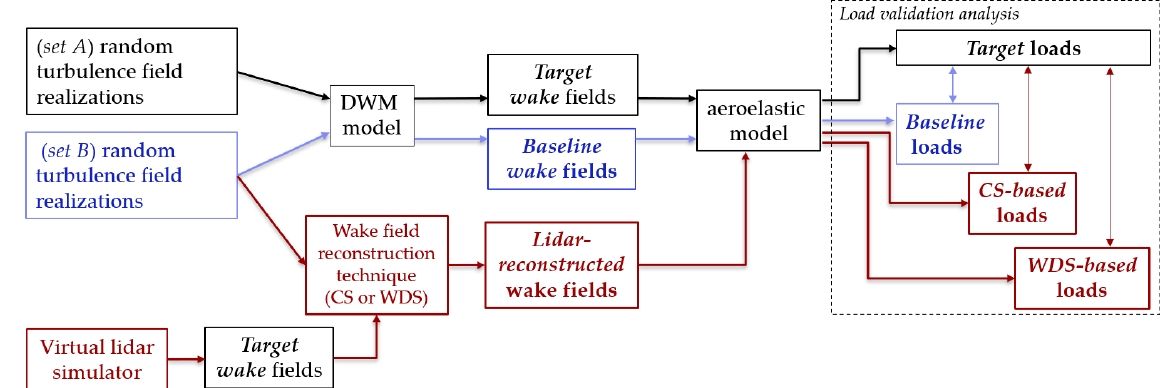
Figure 1. An illustration of the numerical framework utilized to reconstruct wake fields through the DWM model and our proposed lidar- based wake field reconstruction techniques (i.e., the constrained simulations, CSs, and the wake deficit simulations, WDSs). Further, this framework allows quantifying the uncertainty in power and load predictions resulting from aeroelastic simulations with the DWM model- based and lidar-based wake fields. More details can be found in the